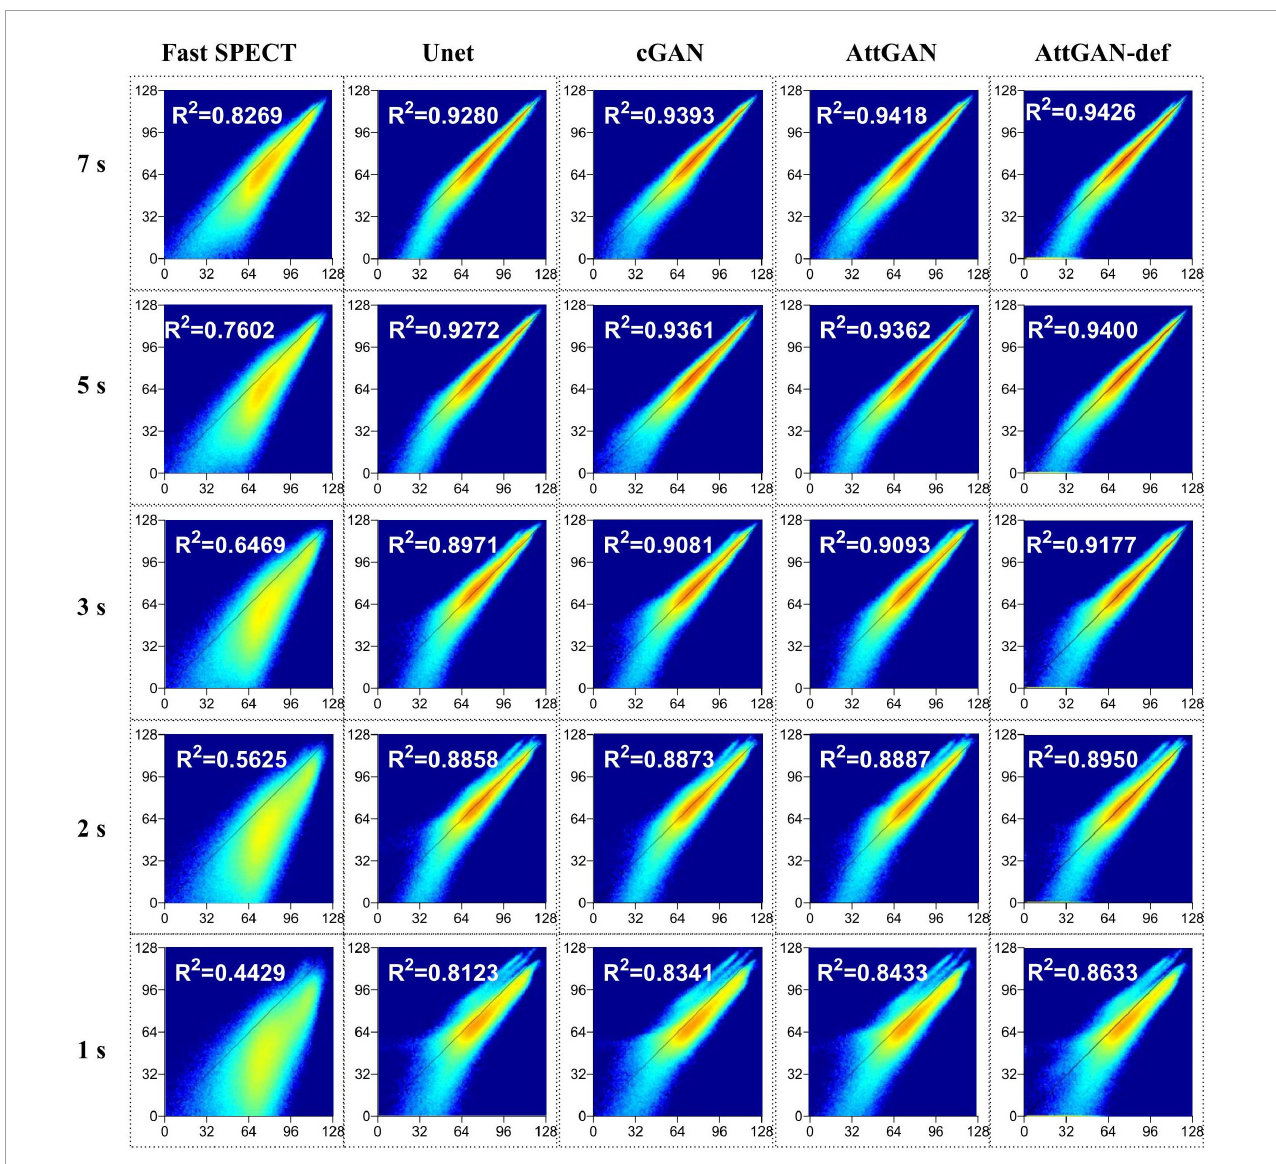
FIGURE8 Joint histogram and linear regression analysis of fast SPECT and different denoised images in the 50 testing datasets for five shorter acquisition times. The filtered FT images are used as the reference.